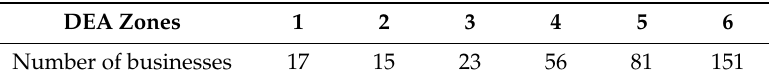
Table 3. Results of a multi-zones ADD